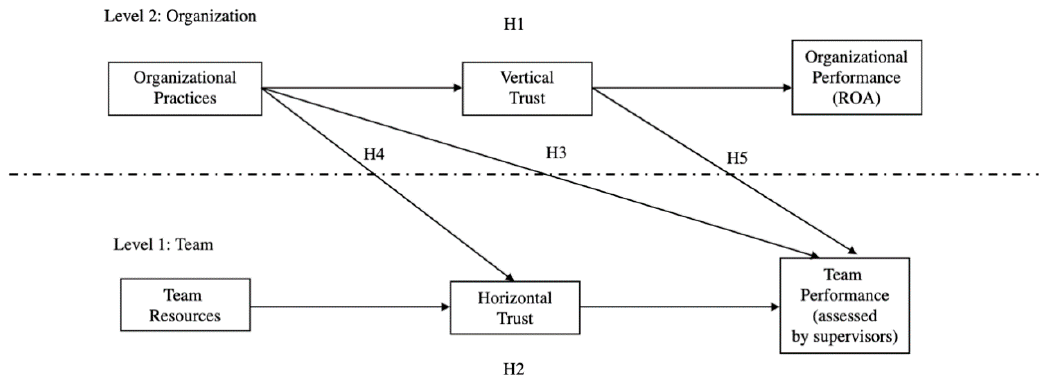
Figure 1. Research model and study hypotheses.